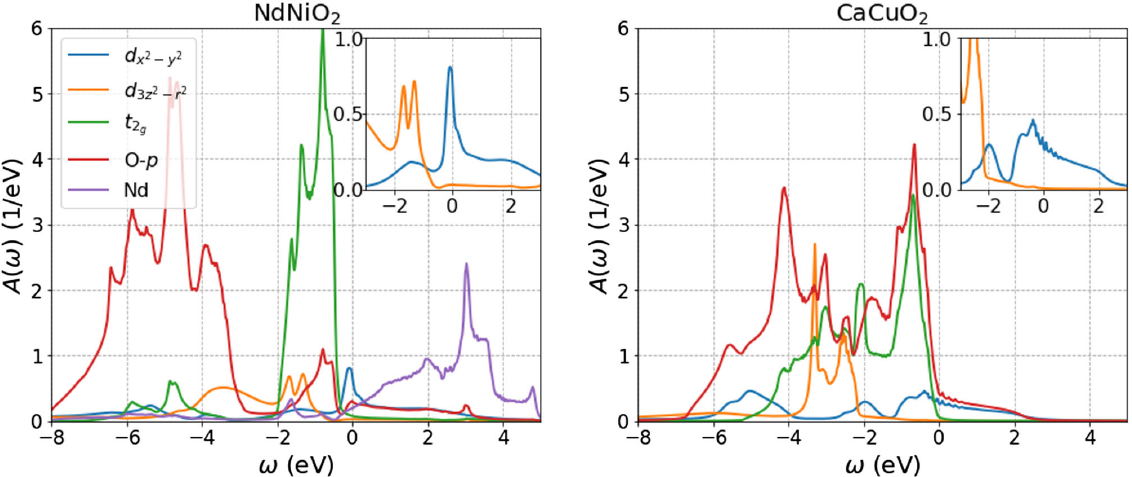
FIG. 1. Main panels: Orbitally resolved wide energy window DFT þ DMFT spectral function summed over spin computed for NdNiO 2 (left-hand panel) and CaCuO 2 (right-hand panel) in the paramagnetic phase, treating the transition metal d orbitals as correlated, with on-site interaction U ¼ 7 eV and J ¼ 0 . 7 eV at temperature T ¼ 290 K. Insets: Expanded view of near chemical potential region showing only d and d 3 contributions to the spectral function. The zero of energy is defined to be the x 2 − y 2 z 2 − r 2 chemical